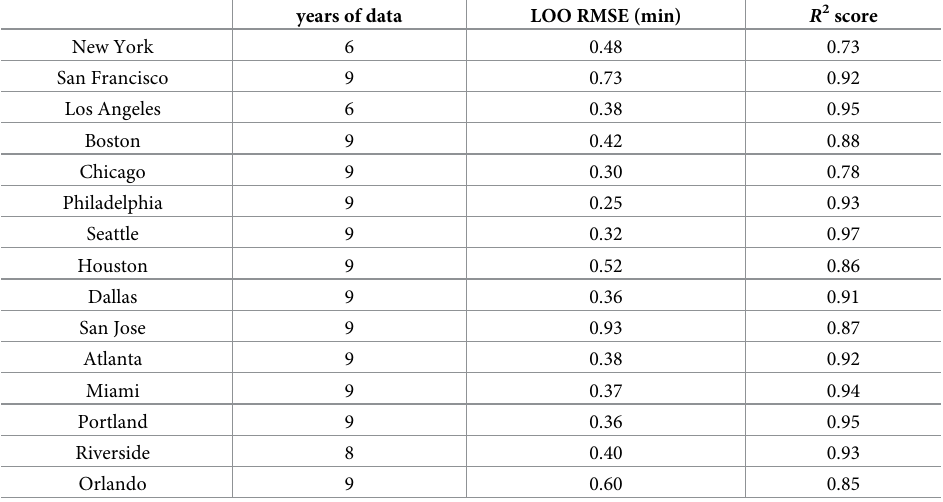
Table 1. Summary of BPR models for 15 metro areas. Years of data available for fitting the model and performance measures for the fitted model. See also S2 Table for a complete